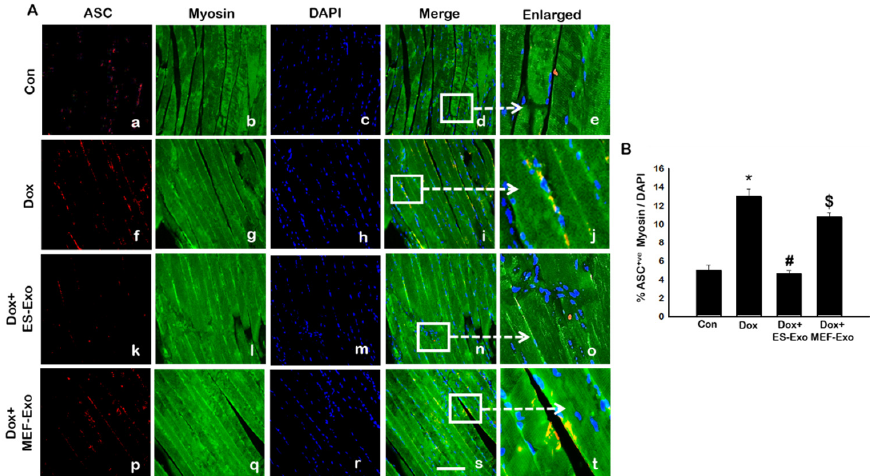
Figure 4. Treatment with ES-Exos inhibits adapter protein, ASC, after Dox administration. ( A ) Representative photomicrographs of soleus muscle sections stained with myosin and adapter protein, ASC. Each box shows ASC + cells in red ( a , f , k , p ), myocytes in green ( b , g , l , q ), DAPI in blue ( c , h , m , r ), merged images ( d , i , n , s ), and enlarged areas of merged images ( e , j , o , t ). ( B ) Histograms from quantitative analysis of ASC + cells over total DAPI. Error bars = mean ± S.E.M. * p < 0.05 vs. control, # p < 0.05 vs. Dox, $ p = non-significant vs. Dox, one-way ANOVA followed by Tukey test; Scale bar = 100 µm, n = 14–16, male and female. Images taken at 40 × magnification.